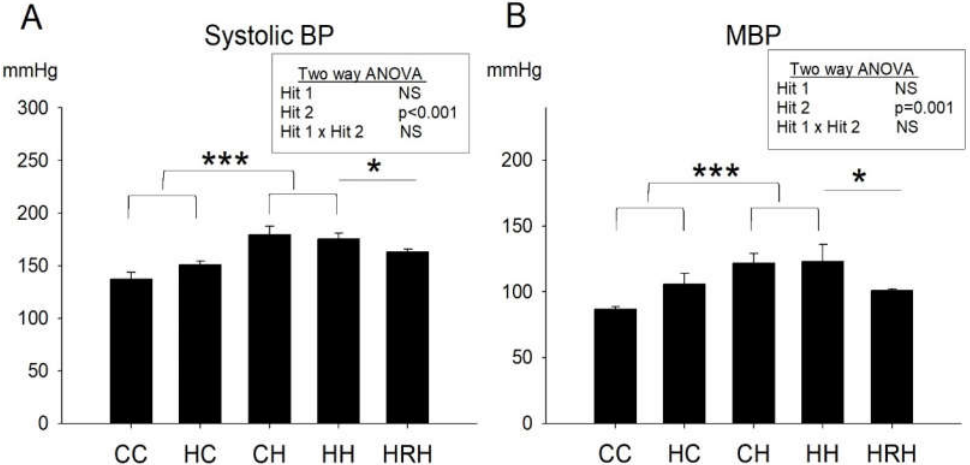
Figure 4. Blood pressures. ( A ) Systolic and ( B ) mean blood pressures of ~4-month-old male rats were analyzed using two-way ANOVA and the therapeutic effect of resveratrol was further evaluated using the Student’s t-test. Postnatal HFD treatment on systolic blood pressures: (F (1,14) = 26.396, p < 0.001). Postnatal HFD treatment on MBP: (F (1,14) = 16.396, p = 0.001). * p < 0.05; *** p < 0.001. BP: blood pressure; MBP: mean blood pressure.